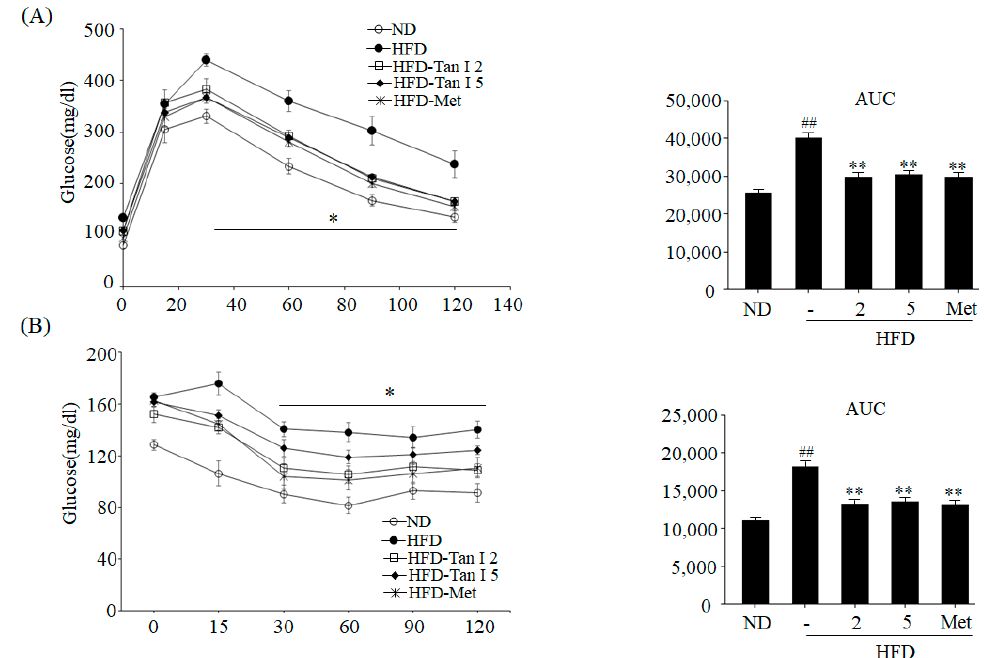
Figure 2. Tan I improved glucose and insulin tolerance in HFD obese mice. ( A ) Intraperitoneal glucose tolerance test (IPGTT) and the glucose area under the curve (AUC) during IPGTT. ( B ) Insulin tolerance test (ITT) and the glucose inverse AUC during ITT. The data are presented as the mean ± SEM of ten mice. ## p < 0.01 vs. ND-fed mice, * p < 0.05, ** p < 0.01 vs. HFD-fed mice. Met means metformin administration.